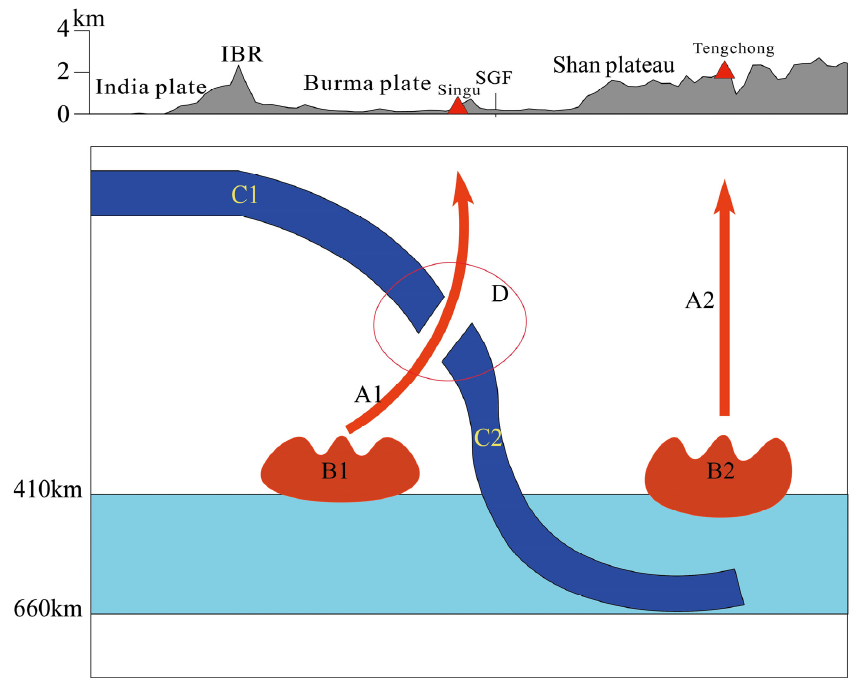
Figure 10. Schematic diagram of the main structural features of the upper mantle in Myanmar and the surrounding areas constructed based on the seismic tomography results of our study and Raoof et al., Jianfeng Yang and Manuele Faccenda [11,58]. This figure locates at the black line in Figure 1. The C1 is the Indian continental lithosphere. The C2 is the Indian oceanic lithosphere. The A1 and A2 represent thermal upwelling, and the red triangles represent volcanoes. The B1 and B2 are the partially molten regions. The D is the slab